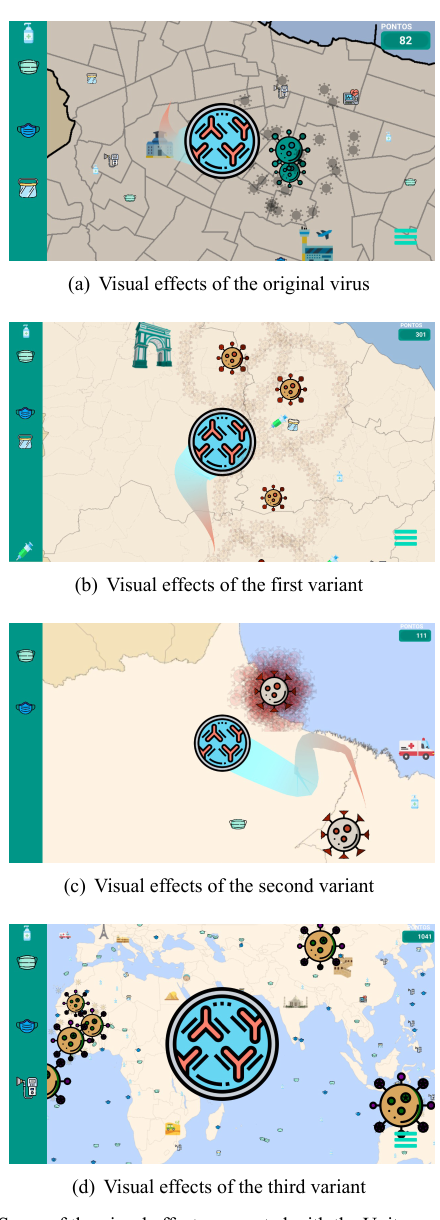
Figure 4. Some of the visual effects generated with the Unity particles sys- tem for the virus and its three variants ( Figure 4 ).